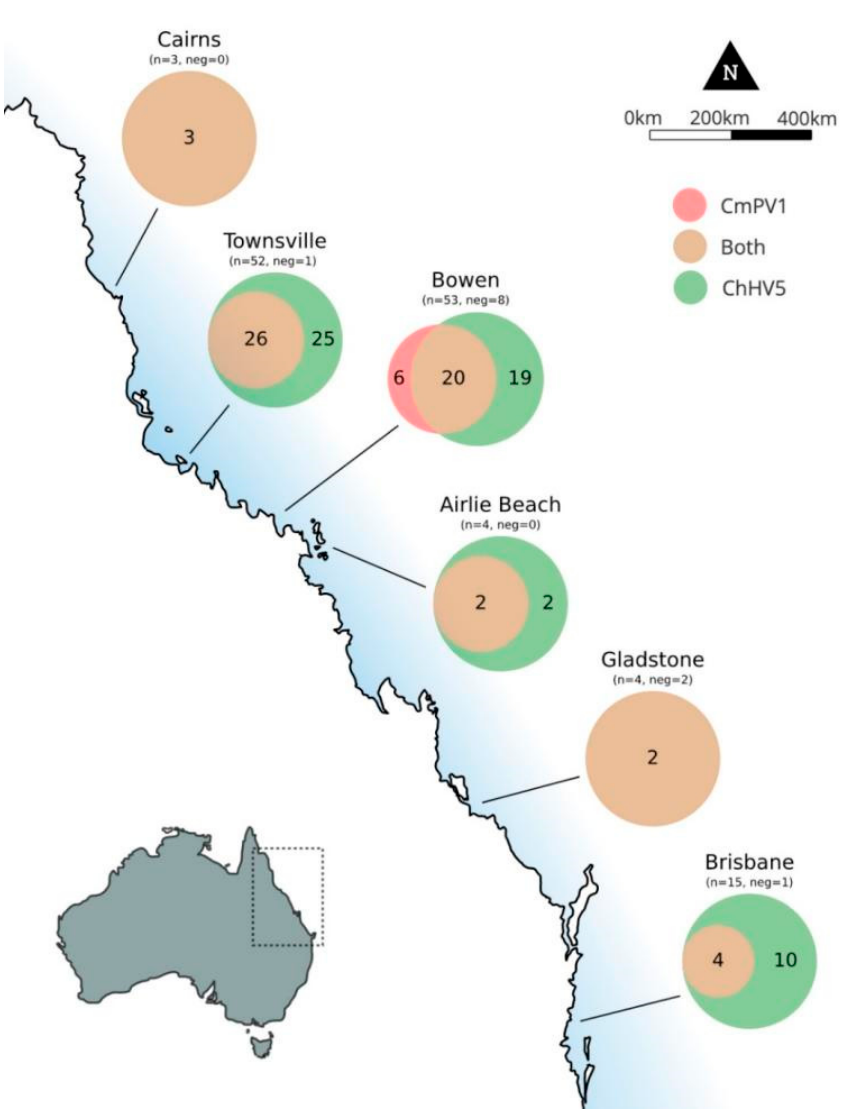
Figure 1. The distribution of chelonid alphaherpesvirus 5 (ChHV5) and Chelonia mydas papilloma- virus 1 (CmPV1) in FP tumour samples (Group A) collected from green turtles at six regions along the Queensland coast. A total of 131 FP tumour tissues were tested. Of the assay samples 62 reacted in the qPCR for CmPV1, 113 for ChHV5, and 12 samples did not react in either assay. 57 turmor samples reacted in both viruses. The viral detection at each site is categorised into three categories: ChHV5 only (red), CmPV1 only (green), both ChHV5 and CmPV1 detected in the same sample (beige). The total number of samples screened (n) and the total number of negatives (neg) are shown for each location.